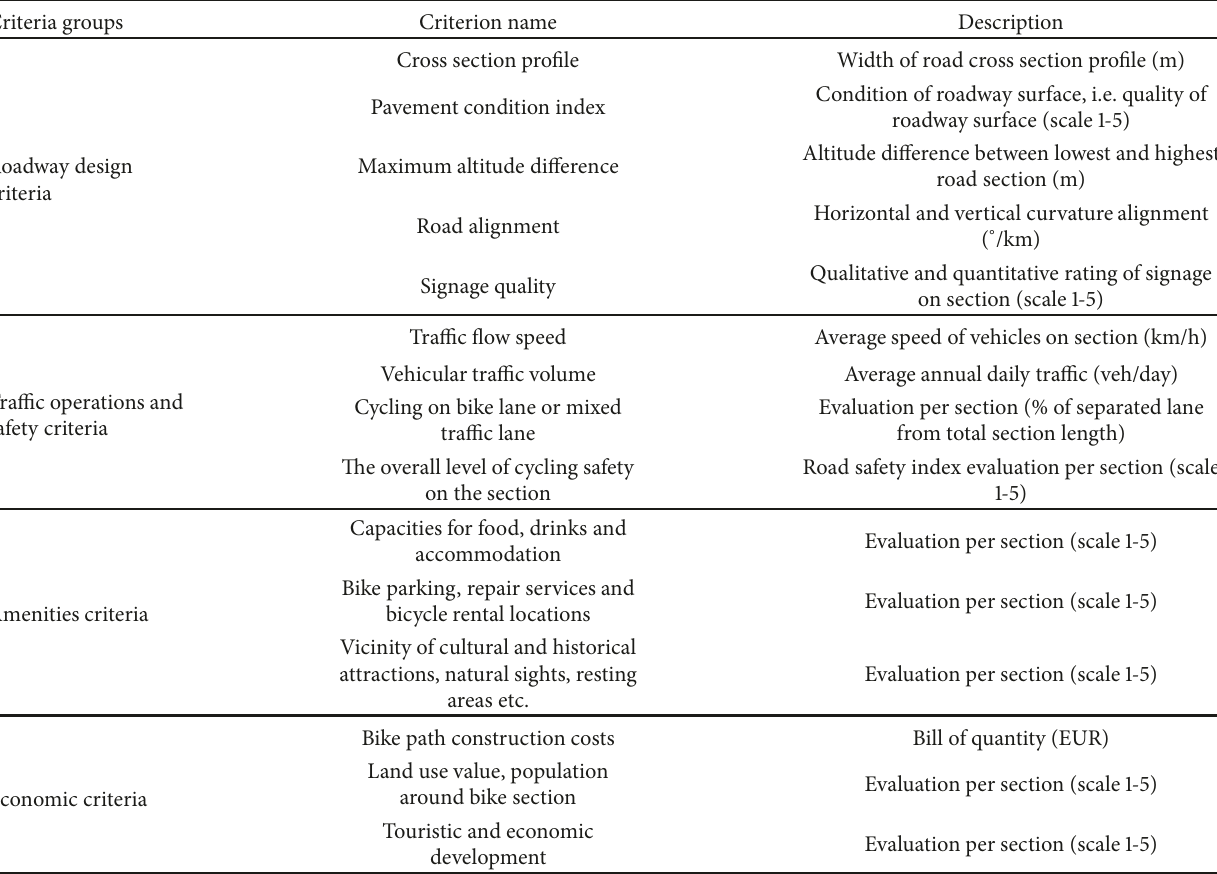
Table 2: Definition of